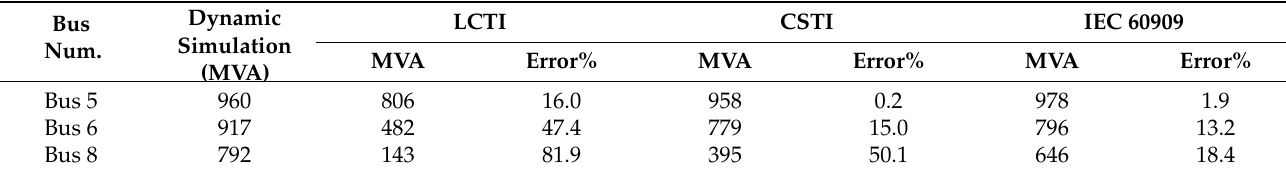
Table 7. Fault level MVA obtained in scenario